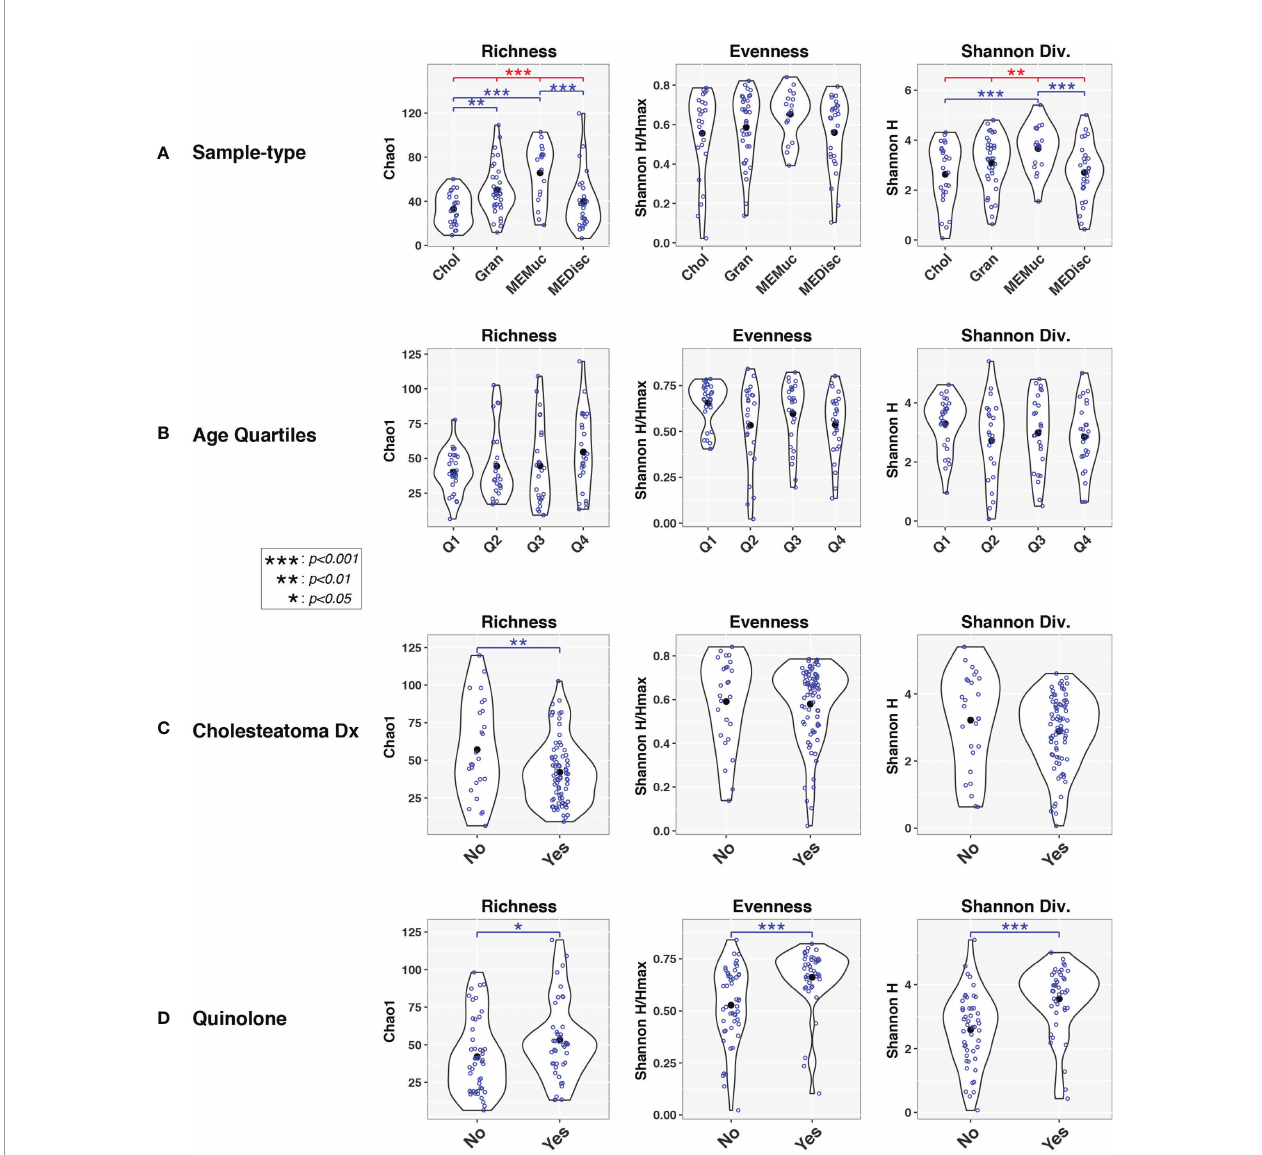
FIGURE 2 | Alpha-diversity indices vary by sample-type and age. Violin plots show within-group distributions of values across sample-types (A) , age quartiles (B) , cholesteatoma diagnosis (C) , or quinolone use (D) . Open blue circles indicate individual samples while fi lled black circles designate group means. Results of linear mixed-effects tests are indicated above violin plots. Red lines/symbols indicate p-values across all four groups. Blue lines/symbols indicate p-values for pairwise comparisons with false discovery rate